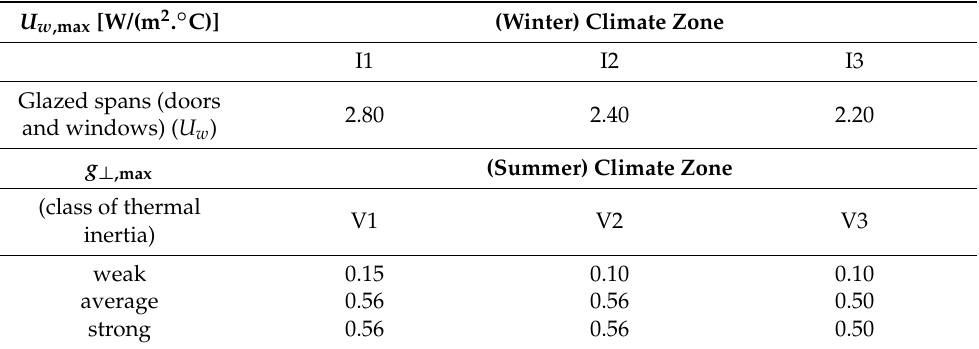
Table 3. Prescriptive window requirements defined by Ordinance 379-A/2015 [37], (since 15 Decem- ber 2015). Maximum value of thermal transmission coefficient ( U w ,max ) and of solar factor ( g ⊥ ,max ) of glazed spans. U w ,max [W/(m 2 . ◦